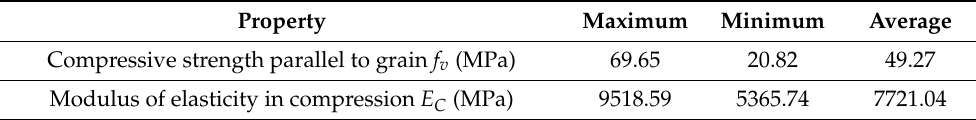
Figure 5. Detail failure at tongue and groove. Table 1. Mechanical performance of TDG laminated bamboo (standard size).